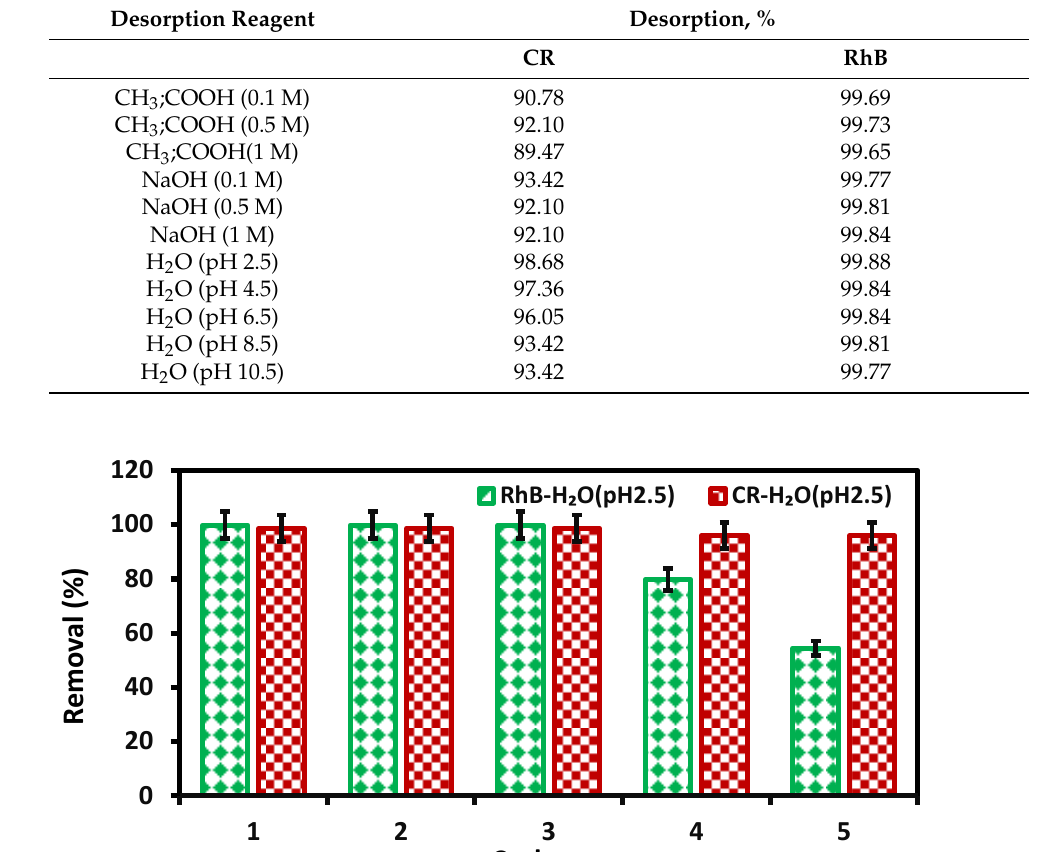
Table 4. Desorption percentage of CR and RhB dyes by PTFAC with different desorption reagents.